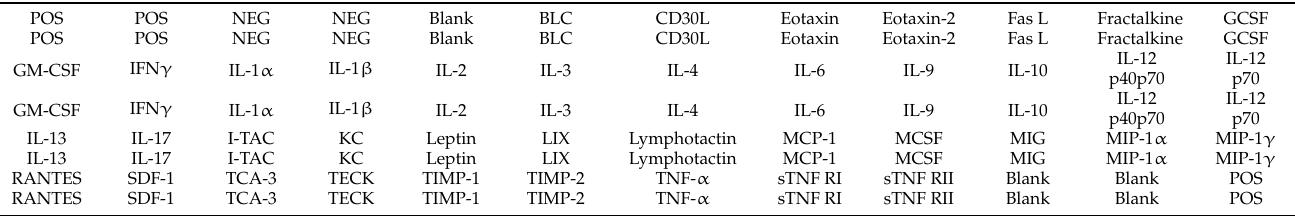
Table 1. Inflammatory array